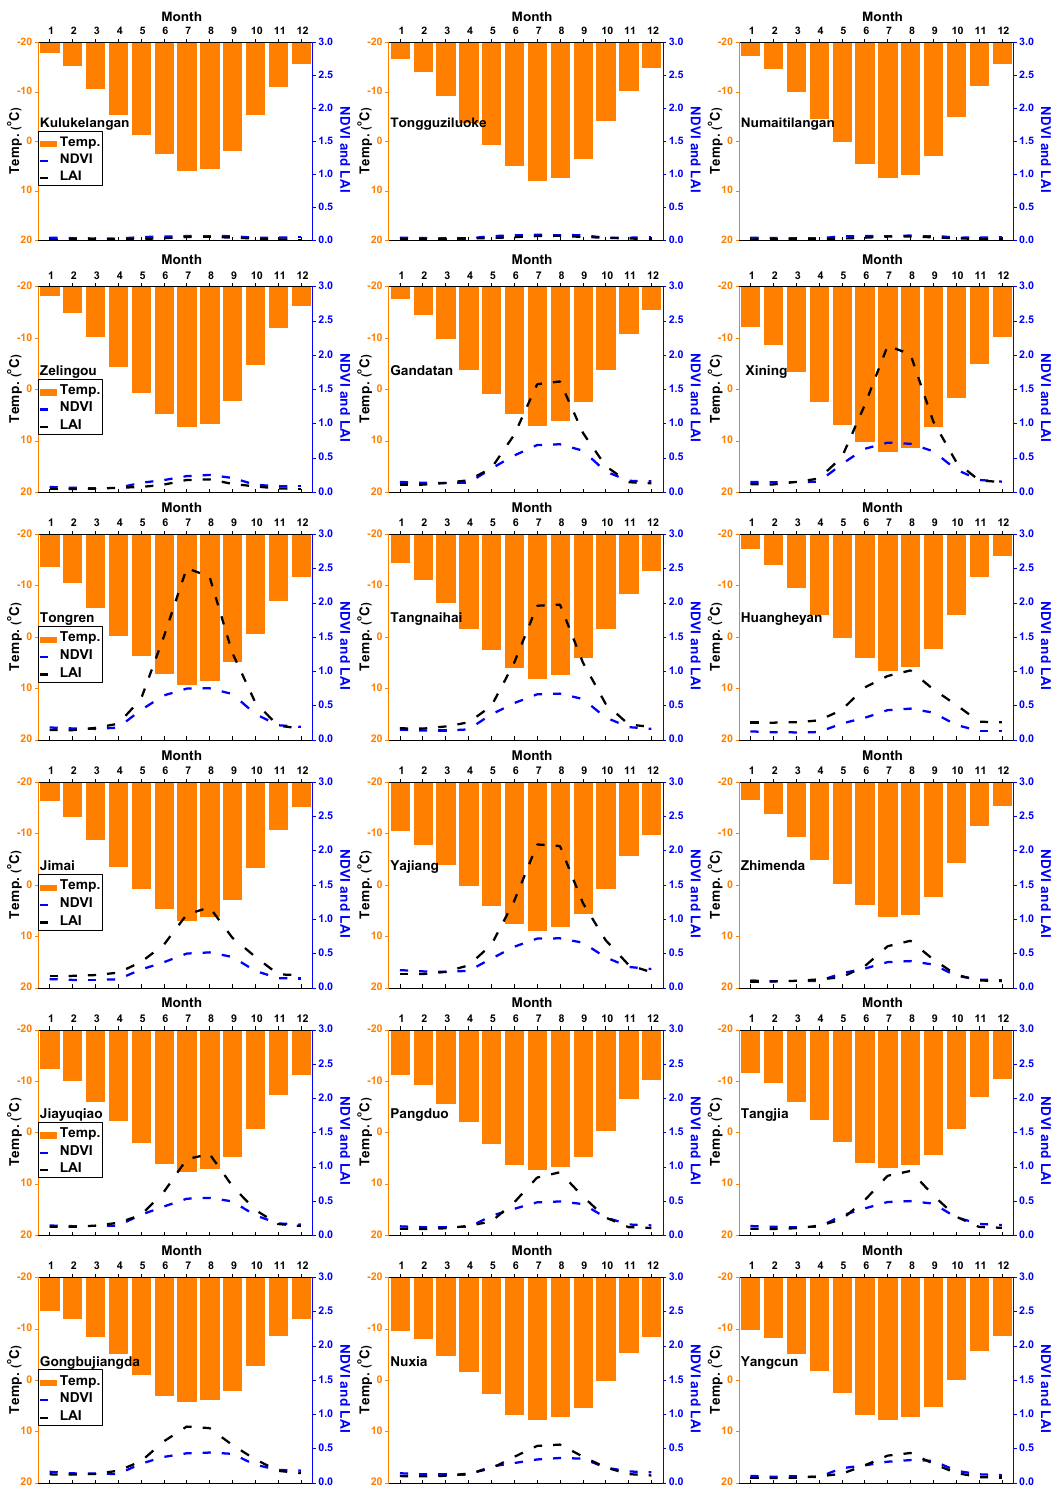
Figure 6. Seasonal cycles (1982–2011) of air temperature and vegetation parameters in westerlies-dominated (row 1), east-Asian-monsoon- dominated (rows 2–4) and Indian-monsoon-dominated (rows 5–6) TP